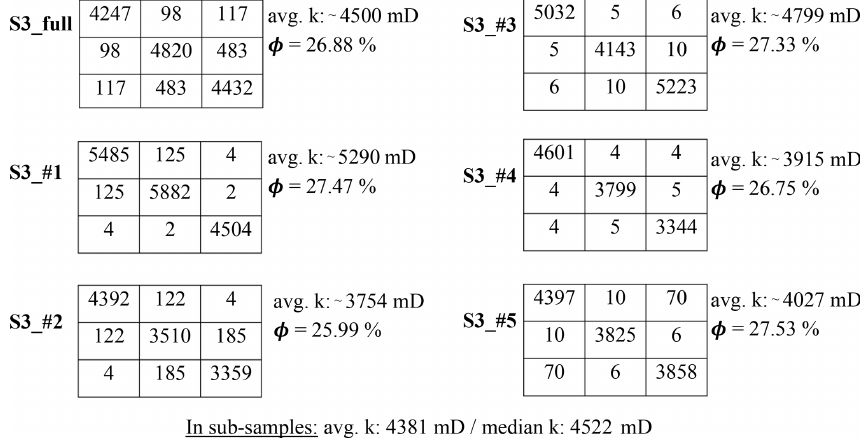
Figure 16. Permeability tensor simulation results and evaluated 3-D image porosity data for the subvolumes and full sample of S3 specified in Fig.